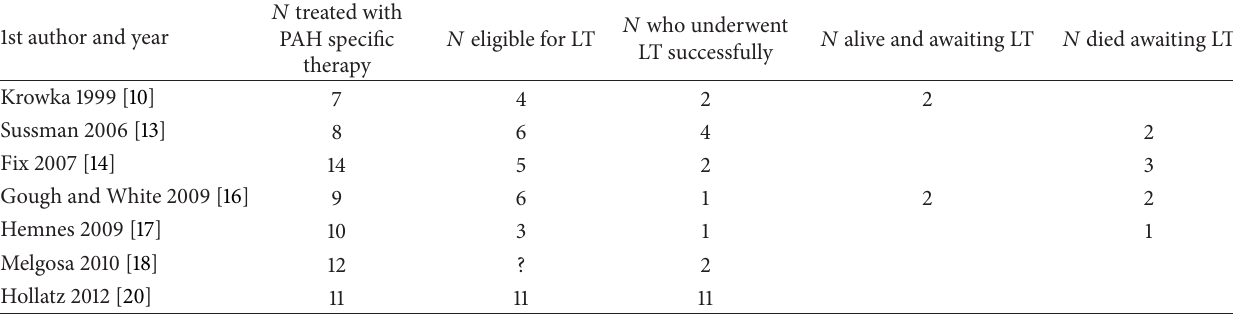
Table 3: Data on liver transplantation [10, 13, 14, 16–18,